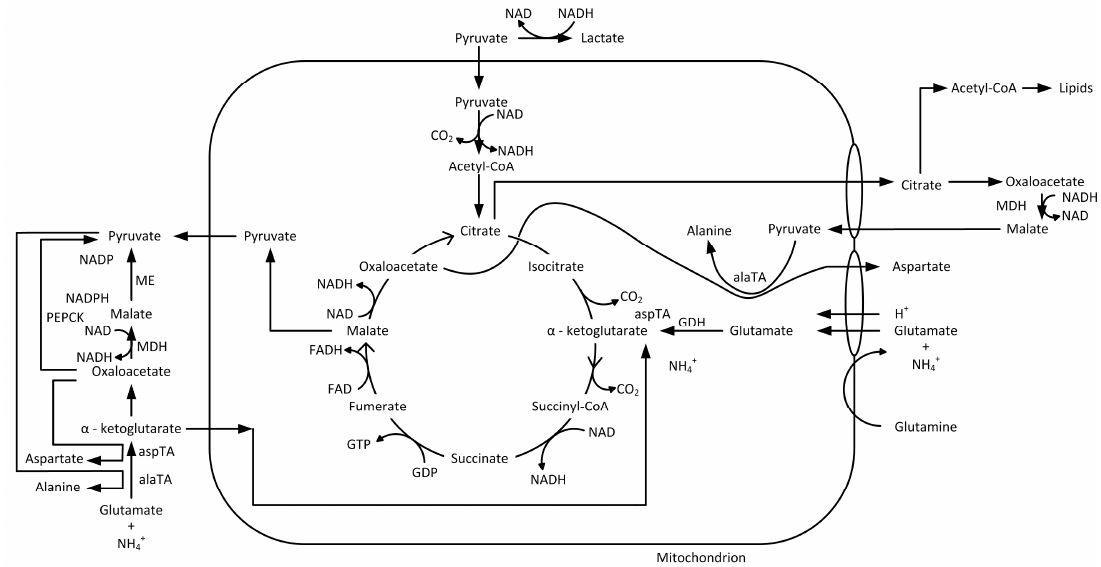
Figure 4. Citrate cycle, which represents the entry point into the energy metabolism, adapted from